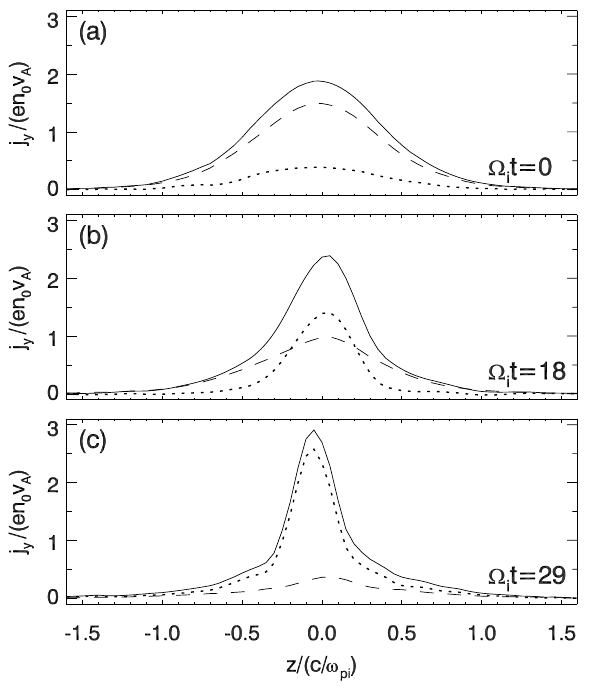
Fig. 2. The profiles of the current sheet along x = 26 . 6 c/ω pi at (a) (cid:127) i t = 0, (b) (cid:127) i t = 18 and (c) (cid:127) i t = 29. The dashed, dotted and solid lines present the electron current j e y , the ion current j i y and the total current j y , respectively.